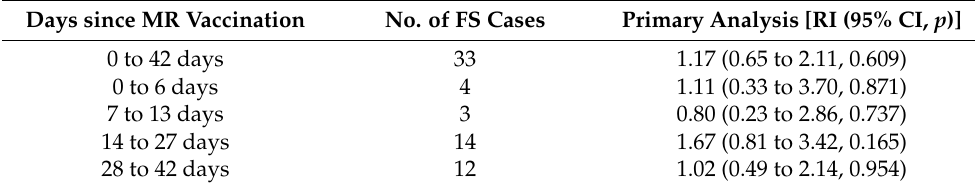
Table 2. Relative incidence of FSs after MR